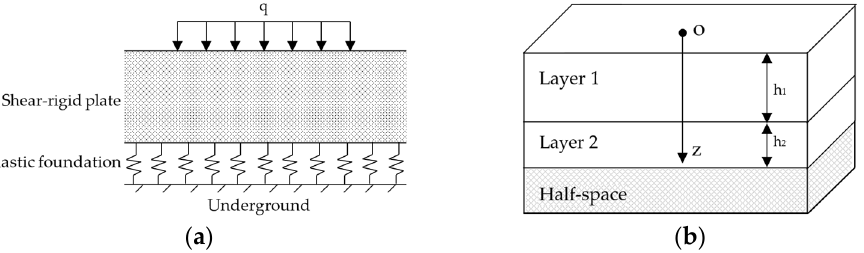
Figure 3. Structural model of elastic-supporting plate under vertical load: ( a ) shear-rigid plate theory on Winkler Foundation; ( b ) isotropic two-layer elastic half-space theory.